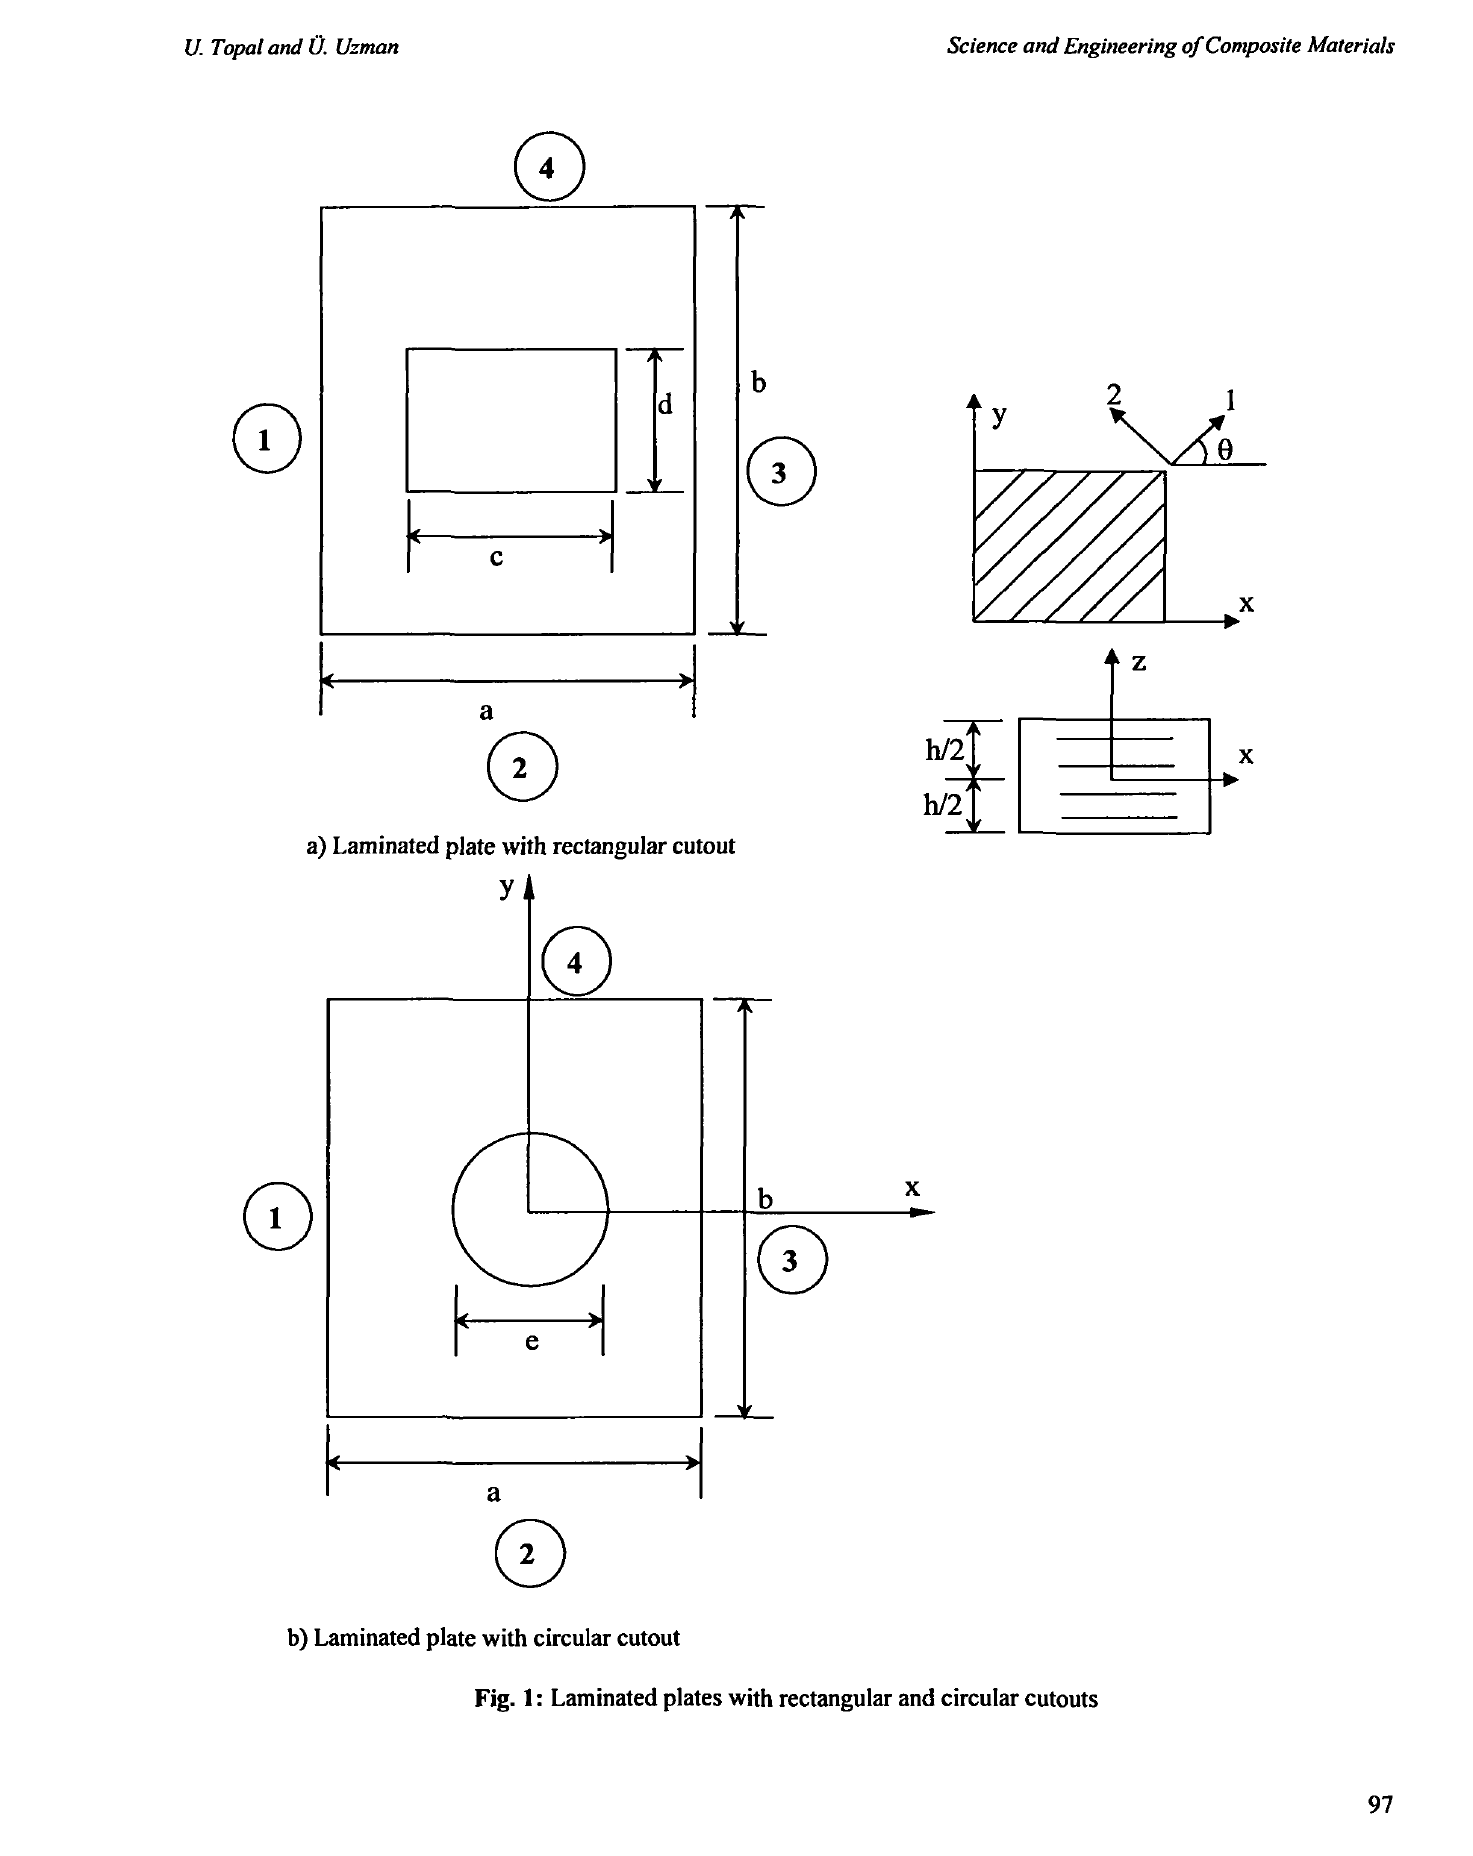
Fig. 1: Laminated plates with rectangular and circular